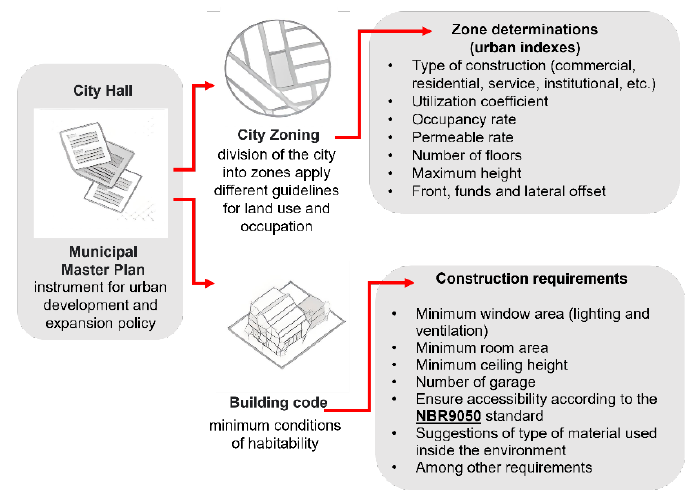
Figure 1. Brazilian legislation.